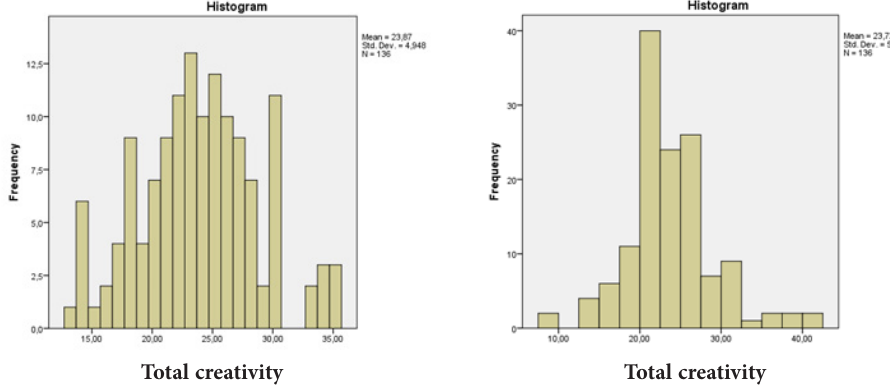
Total creativity Total creativity Figure 1. Histograms of the total scores of Torrance Test of Creative Thinking (Figural Form A) ob- tained from the 9th- and 12th-grade application results (source: created by author)